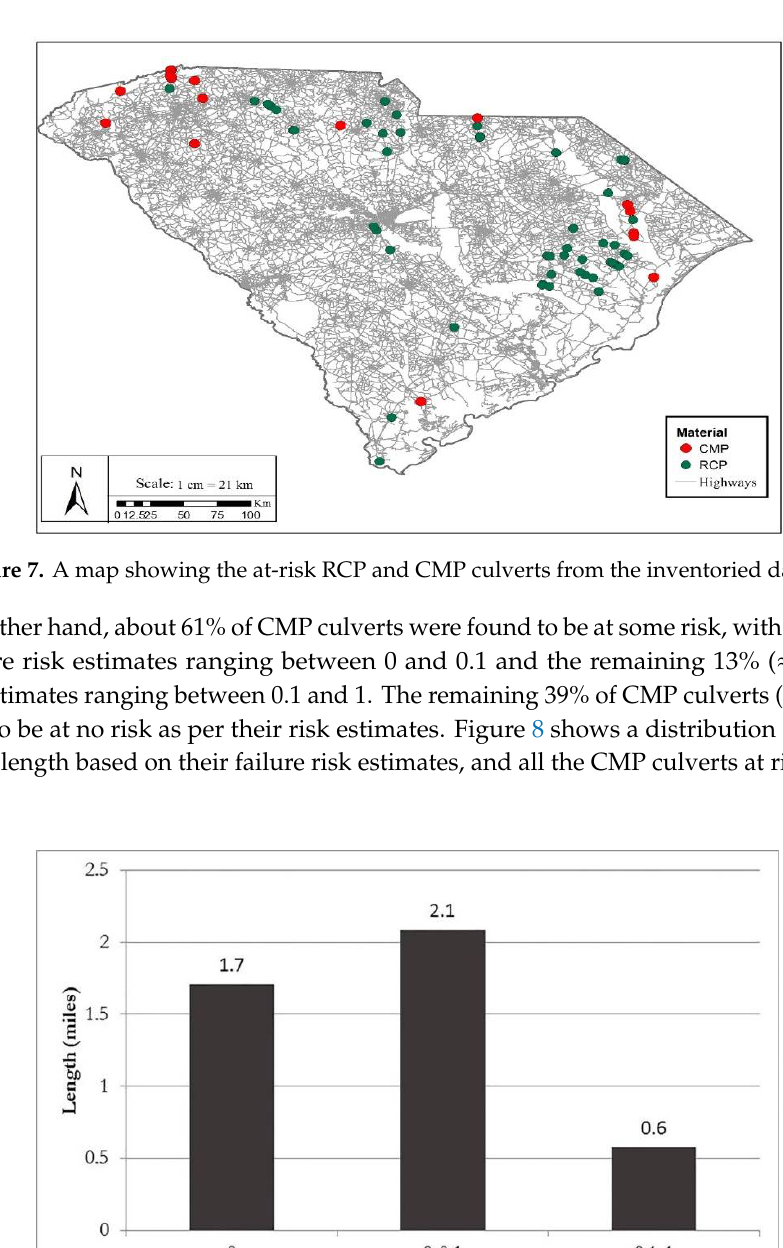
Figure 6. Failure risk analysis of RCP culverts: risk vs. length.